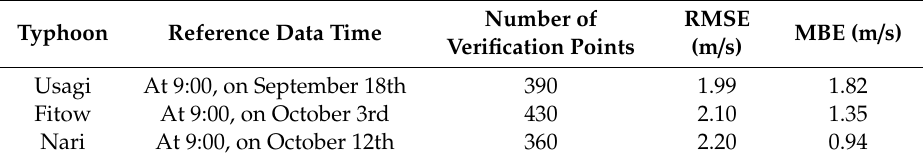
Table 3. The metrics results for typhoons Usagi, Fitow, and Nari.